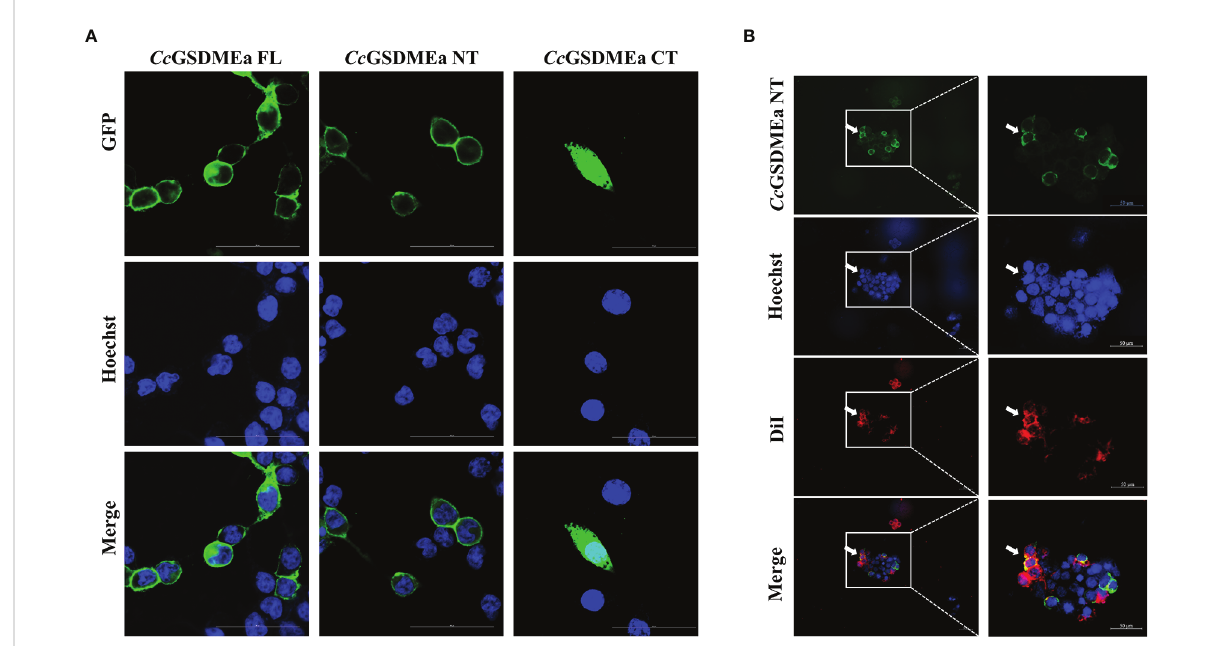
FIGURE 5 Subcellular localizations of Cc GSDMEa different forms. (A) Subcellular localizations of Cc GSDMEa-FL/NT/CT and Hoechst-stained nucleus in HEK293T cells. (B) Subcellular localization of Cc GSDMEa-NT, Hoechst-stained nucleus and DiI-stained cytomembrane in HEK293T cells (white arrowheads). The original microscope images were on the left and the locally enlarged images were on the right in (B)